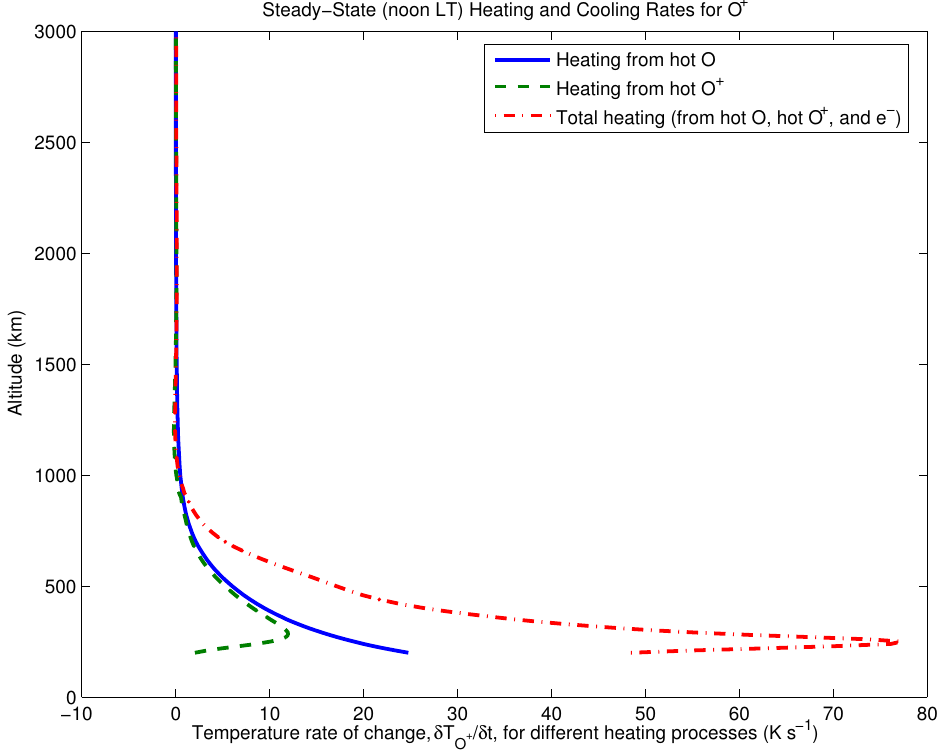
Fig. 5. O + noontime heating rates due to collisions with hot O, hot O + , and e − . The total steady-state cooling rate (from collisions with neutral atoms) is equal to the total heating rate shown above.